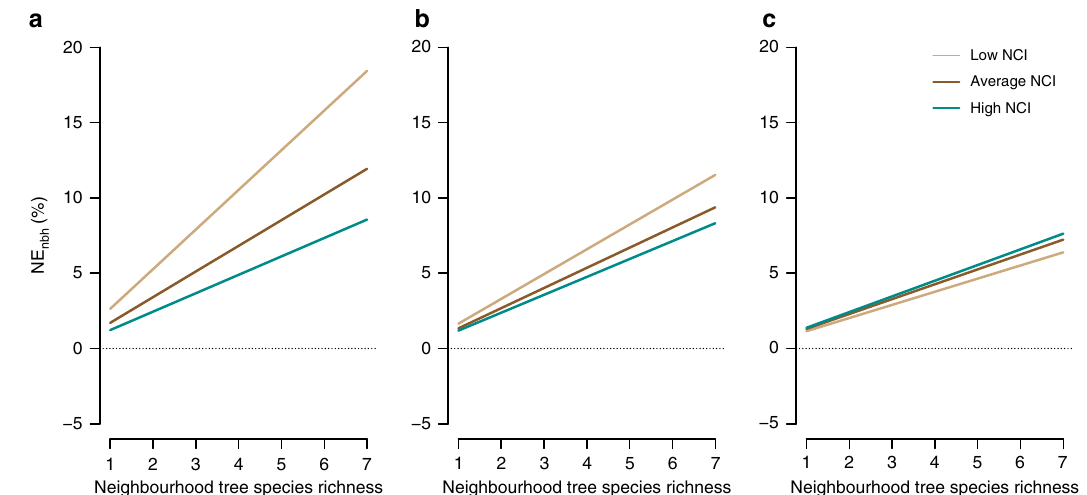
Fig. 1 Biodiversity effects on individual tree growth. Size-dependent variation in net biodiversity effects at the neighbourhood scale (NE nbh ) with neighbourhood competition and neighbourhood tree species richness (NSR). NE nbh indicates the predicted change (%) in individual tree growth (annual growth rate of wood volume of a focal tree growing with heterospeci fi c compared to growing with conspeci fi c neighbours) in response to neighbourhood tree species richness at low, average and high value of neighbourhood competition index (NCI) for a small-sized, b medium-sized and c large-sized trees. Lines represent mixed-effects model fi ts for each size and competition level, respectively. Tree size, NCI and NSR explained 48% of the variation in